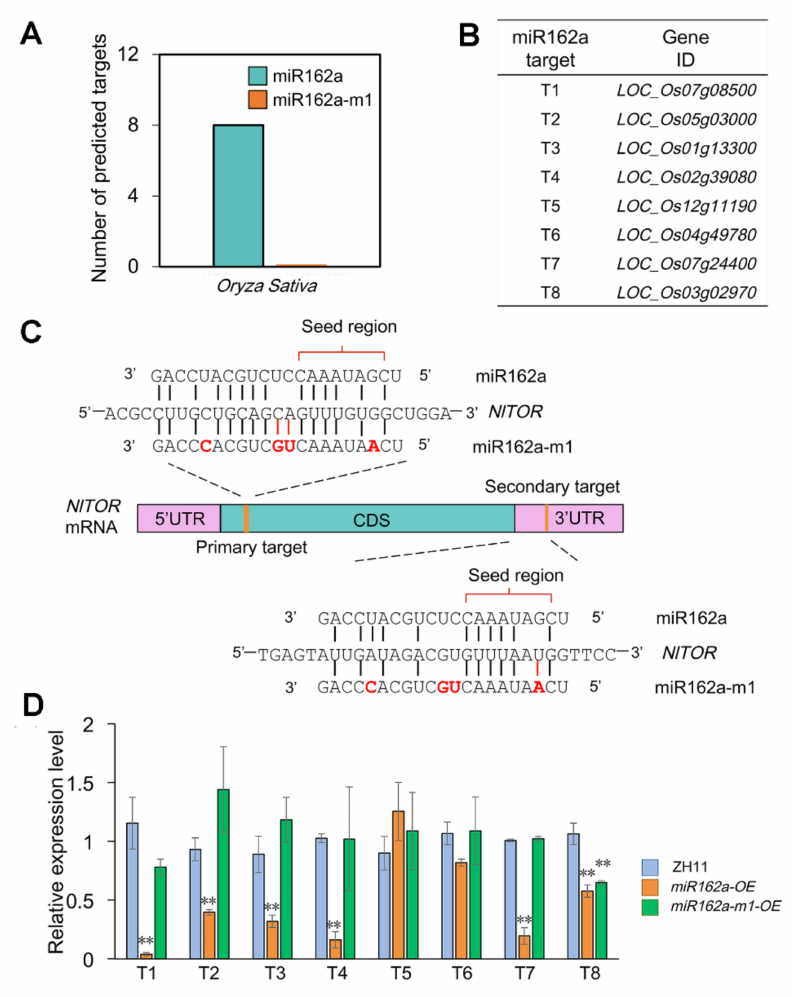
Figure 3. osa-miR162a-m1 exhibits minimal perturbation on rice endogenous gene expres- sion. ( A ) Predicted target gene numbers of osa-miR162a and its derivative osa-miR162a-m1 by WMD. ( B ) Predicted rice target genes of osa-miR162a by WMD. ( C ) osa-miR162a-m1 exhibits ad- ditional base matches to the primary target site of NlTOR and improved complementarity to the seed region of the secondary target site of NlTOR relative to osa-miR162a. The modified nucleotides and newly gained base pairings in osa-miR162a-m1 are highlighted in red. ( D ) Overexpression (OE) of osa-miR162a-m1 exhibits much less perturbation on rice endogenous gene expression than osa-miR162a. The expression levels of putative target genes were determined by RT-qPCR and the data are shown as mean ± SD of three biological replicates ( n = 3). ** p < 0.01 (Student’s t